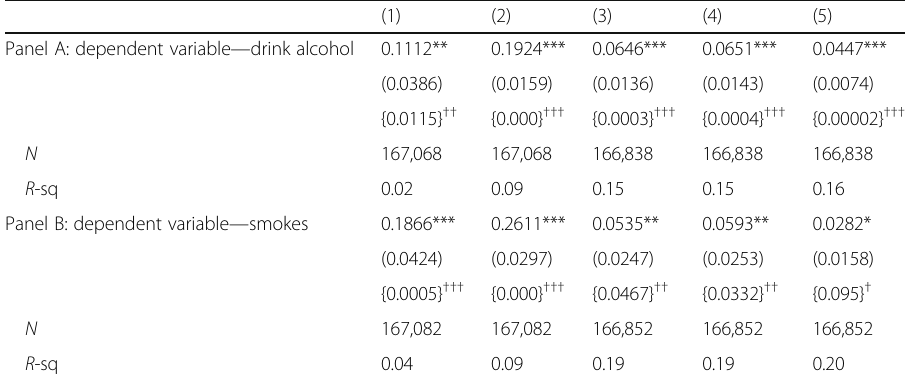
Table 8 The effect of MLDA on drinking and smoking in states never under prohibition (sample: all men 15 – 50 years